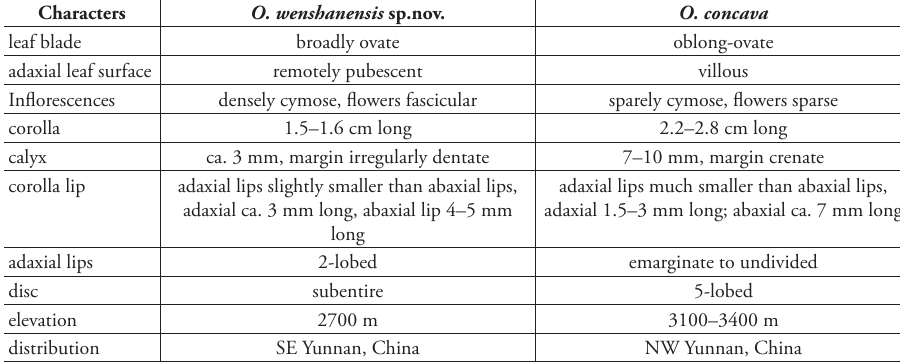
Table 4. Differences between Oreocharis wenshanensis and O. concava in